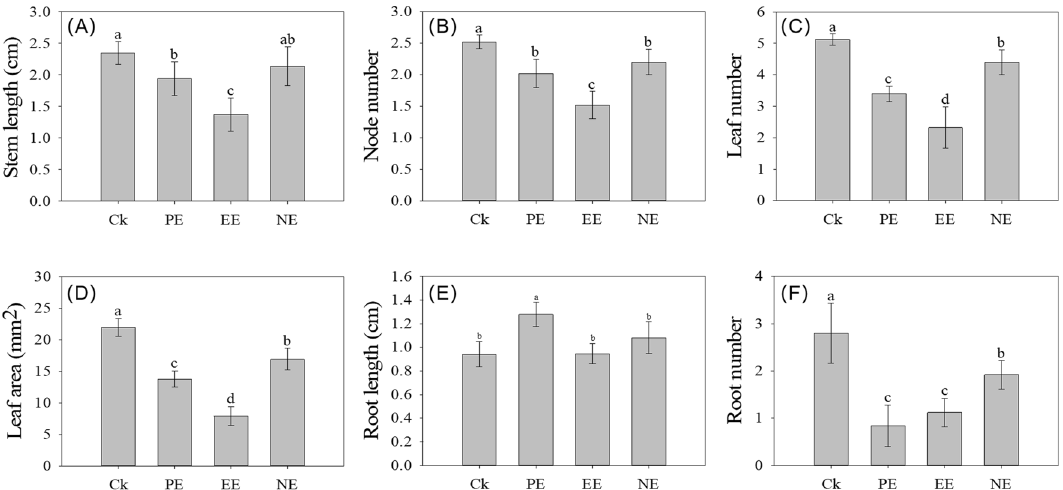
Figure 1. The effects of different subsurface extracts on the growth of A. philoxeoides . ( A ) stem length and ( B ) node number of ramets and ( C ) leaf number of ramets and ( D ) leaf area and ( E ) root length and ( F ) root number of A. phlioxeoldes (from left to right, the columns are control, Petroleum ether (PE), ethyl acetate (EE) and n-Butanol (NE)). The bars in the figure stand for the Std. Deviation of the replications (n = 5). The treatments with the same letter are not significantly difference at 0.05